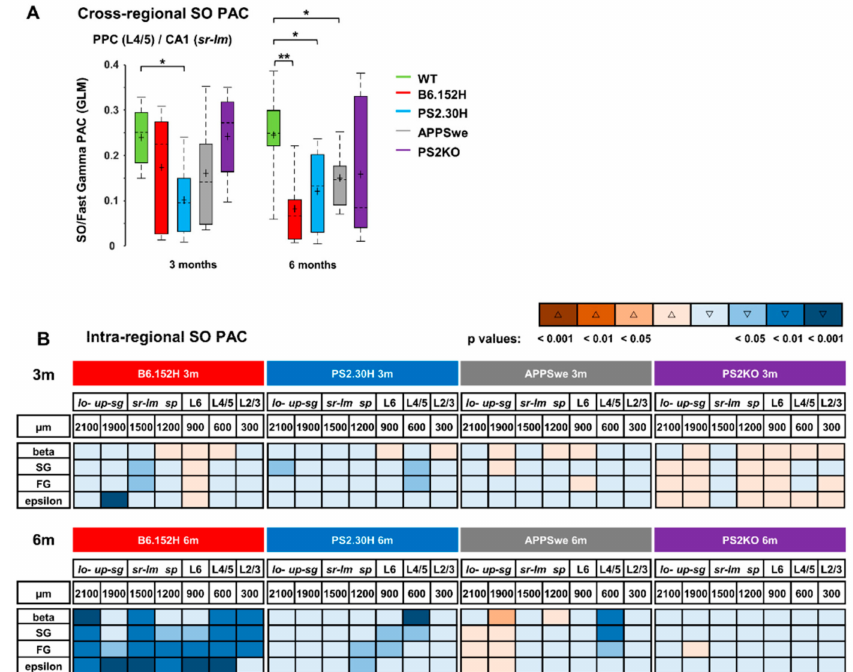
Figure 7. Reduced SO Phase-Amplitude Coupling in AD mice. PAC between SO and higher frequencies was measured by the GLM index as described in Supplementary Materials. The cross-regional PAC was measured between SO in PPC and higher frequencies in the HPF. Significant impairment was found between SO in L4 / 5 and FG in CA1 ( sr-lm ) ( A ), ** p < 0.01; * p < 0.05.The intraregional PAC was measured between SO and higher frequencies at each depth ( B ). Changes were color-coded in terms of increase ( ∆ ) or decrease ( (cid:53) ) and statistical significance with respect to three- (upper panel) and six- (lower panel) month-old WT